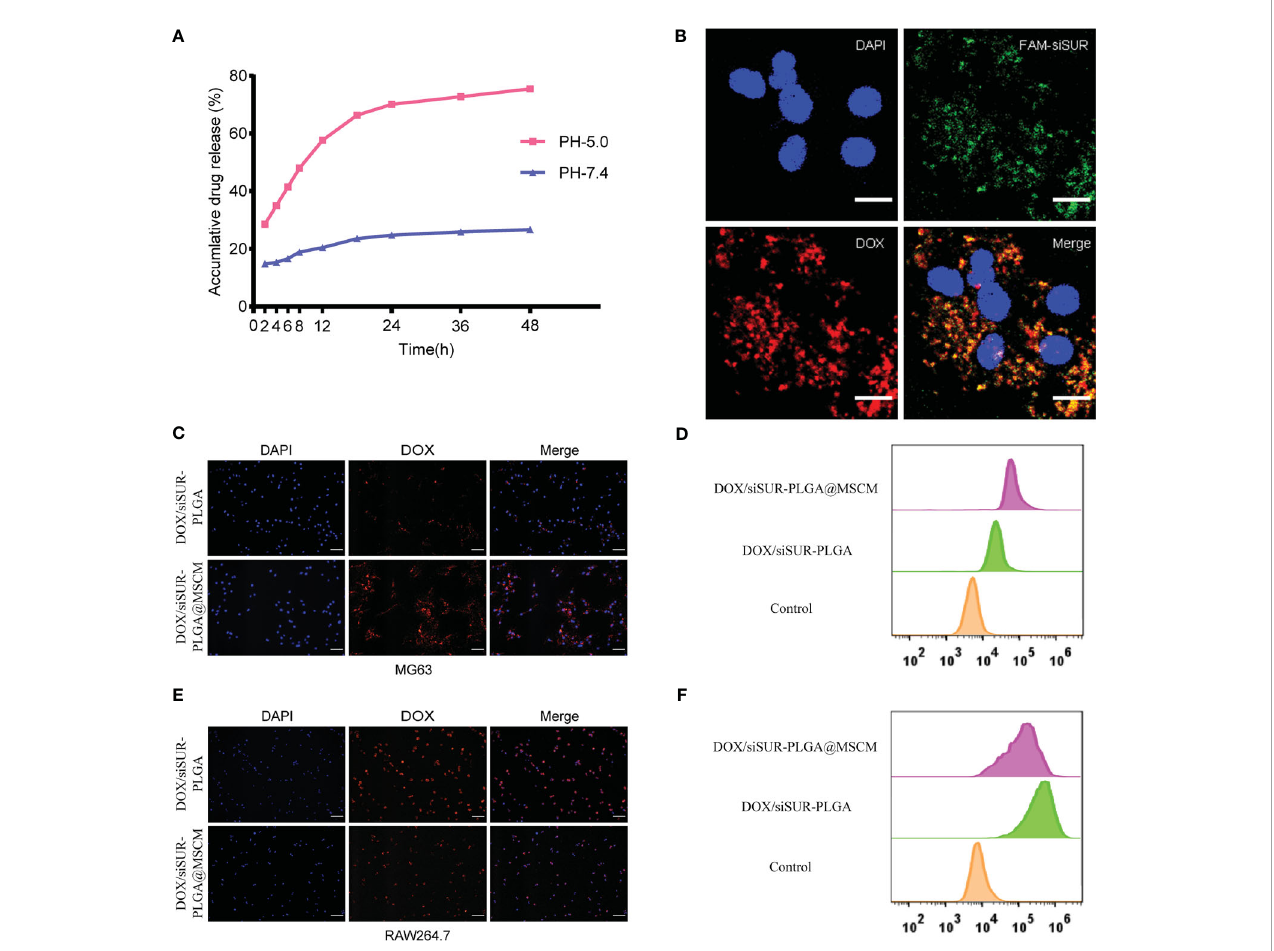
FIGURE 3 In vitro validation of the in vitro release effect, cotransport ability, tumor-homing property and immune escape ability of DOX/siSUR-PLGA@MSCM nanoparticles. (A) In vitro release of DOX at pH 5.0 and pH 7.4. (B) CLSM image of the DOX/siSUR-PLGA@MSCM nanoparticles after being taken up by MG63 cells. DOX self- fl uorescence (red), FAM-labeled siSUR (green), and MG63 cell nuclei stained with DAPI (blue). Scale bar, 20 m m. (C) MG63 cells were treated with DOX/siSUR-PLGA and DOX/siSUR-PLGA@MSCM NPs, and phagocytosis was observed by fl uorescence microscopy using the fl uorescence of DOX (red); nuclei were stained with DAPI. Scale bar, 100 m m. (D) MG63 cells were cocultured with nanoparticles for 3 hours, and then nanoparticle phagocytosis was detected by fl ow cytometry. (E) RAW264.7 cells were treated with DOX/siSUR-PLGA NPs and DOX/siSUR-PLGA@MSCM NPs and phagocytosis was observed by fl uorescence microscopy using the fl uorescence of DOX (red); nuclei were stained with DAPI. Scale bar, 100 m